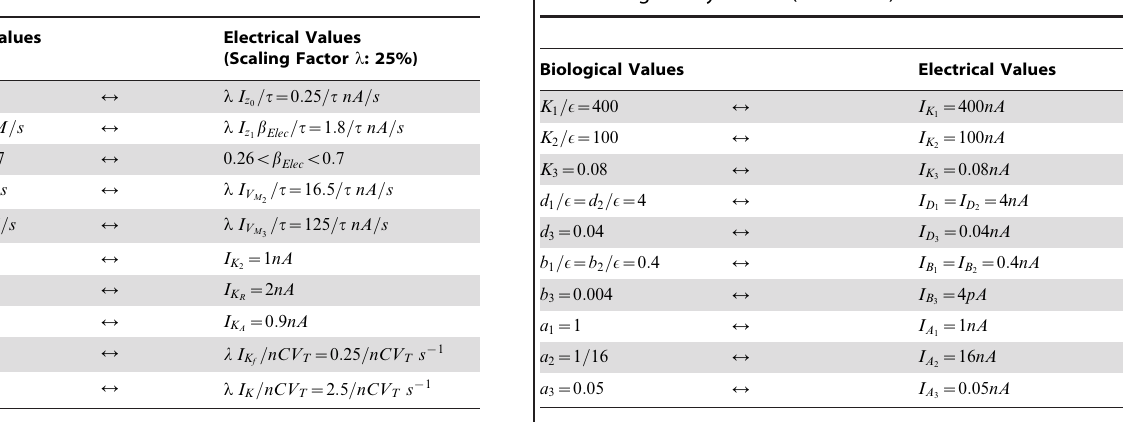
Table 6. Biological And Electrical Values For The Ca 2 z Oscillations Model ( m ~ n ~ 2, p ~ 4 Case).